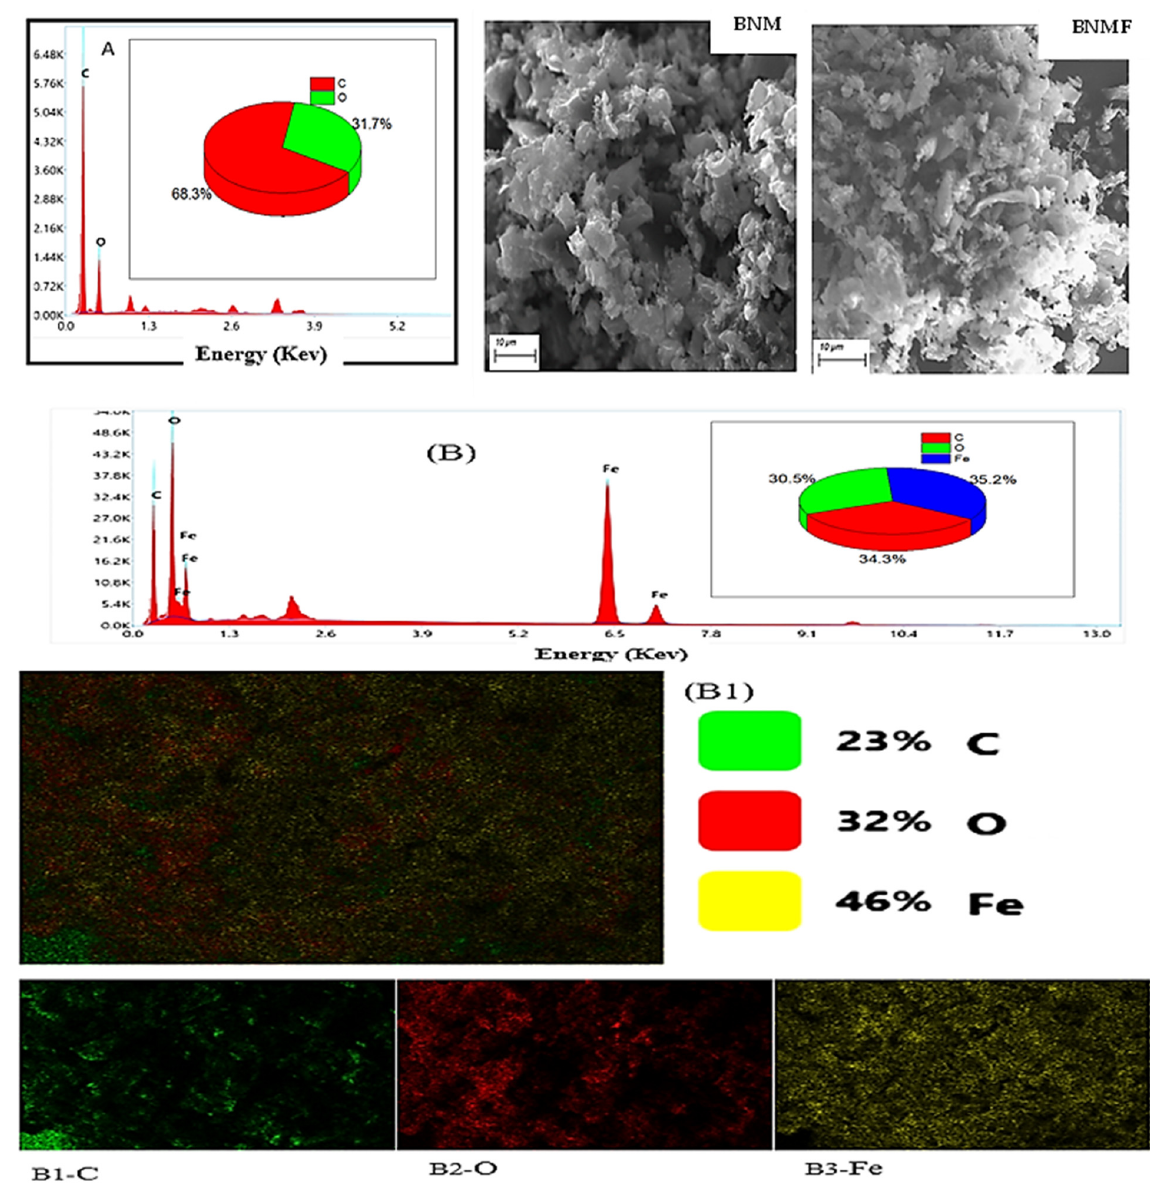
Figure 3. EDX images of non-modified biochar ( A ) and ferromagnetic biochar ( B ), SEM images of non-modified biochar (BNM) and ferromagnetic biochar (BNMF), elemental mapping for ferromagnetic biochar from image B1–B3.